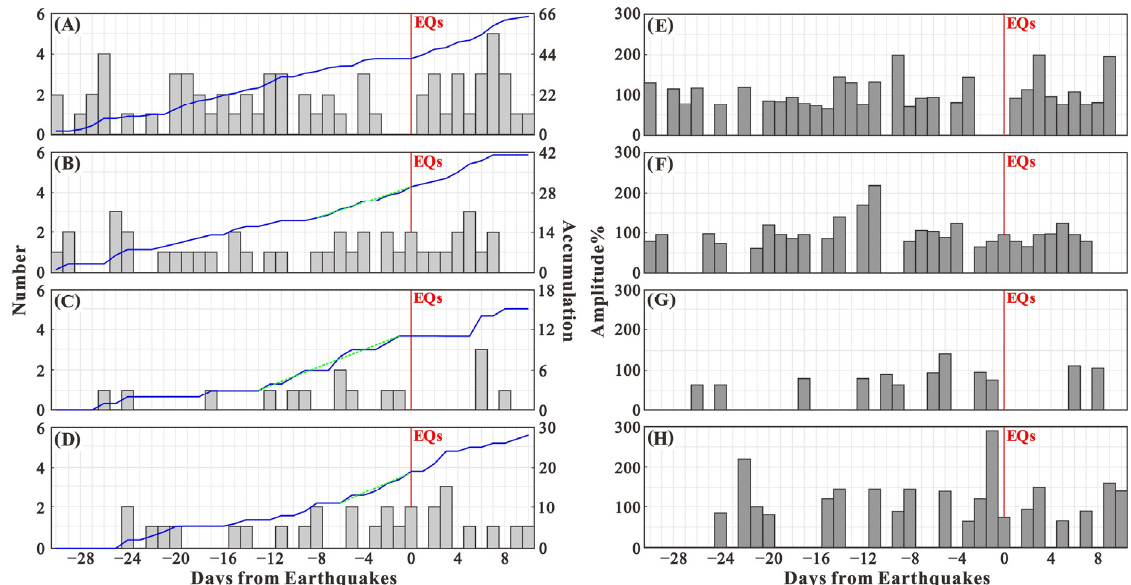
Figure 5. ( A – D ) Relationship between the number of days before or after the earthquakes with magnitudes of 5.0 ‒ 5.4, 5.5 ‒ 5.9, 6.0 ‒ 6.4, 6.5 ‒ 6.9, respectively, and the number of anomalies. The blue lines represent the accumulation of anomalies. The dotted green lines represent the trend of the accumulation of anomalies. ( E – H ) Relationship between the number of days before or after the earthquakes with magnitudes of 5.0 ‒ 5.4, 5.5 ‒ 5.9, 6.0 ‒ 6.4, 6.5 ‒ 6.9, respectively, and the amplitude of anomalies.